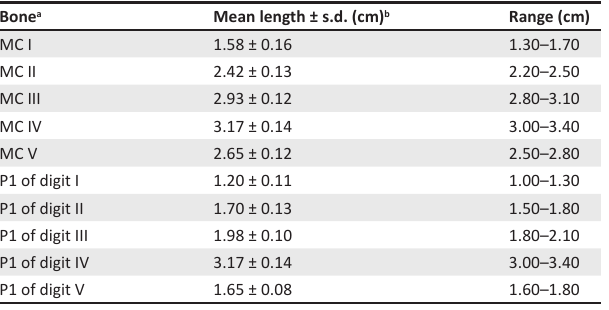
TABLE 2: Radiographic measurements of metacarpal bones and phalanges in captive red pandas. Bone a